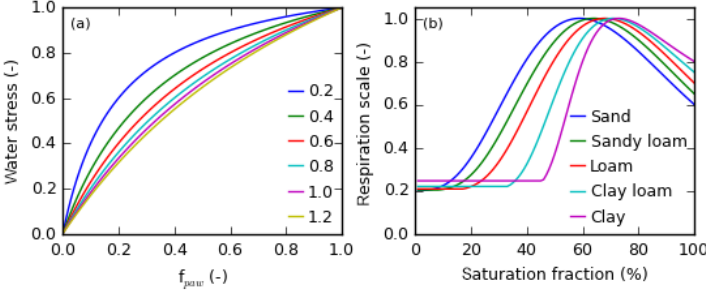
Figure 1. (a) The water stress function in SiBCASA as a function of plant available water fraction. The scaling function is shown for various shape parameters (see legend). The default value for the shape parameter is 0.2 for all biome types. (b) The heterotrophic respiration scaling function in SiBCASA as a function of soil moisture saturation fraction and soil